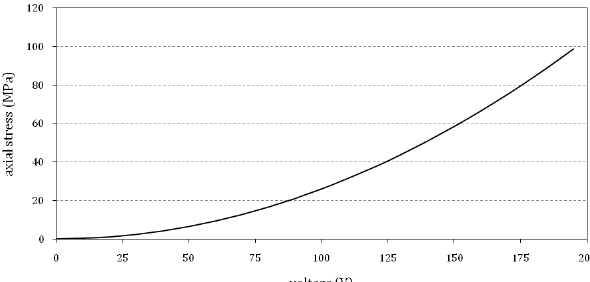
Figure 6: Static voltage-stress conversion curve for tensile loading device (design 2) from FEM simulations constrained with experimental values of